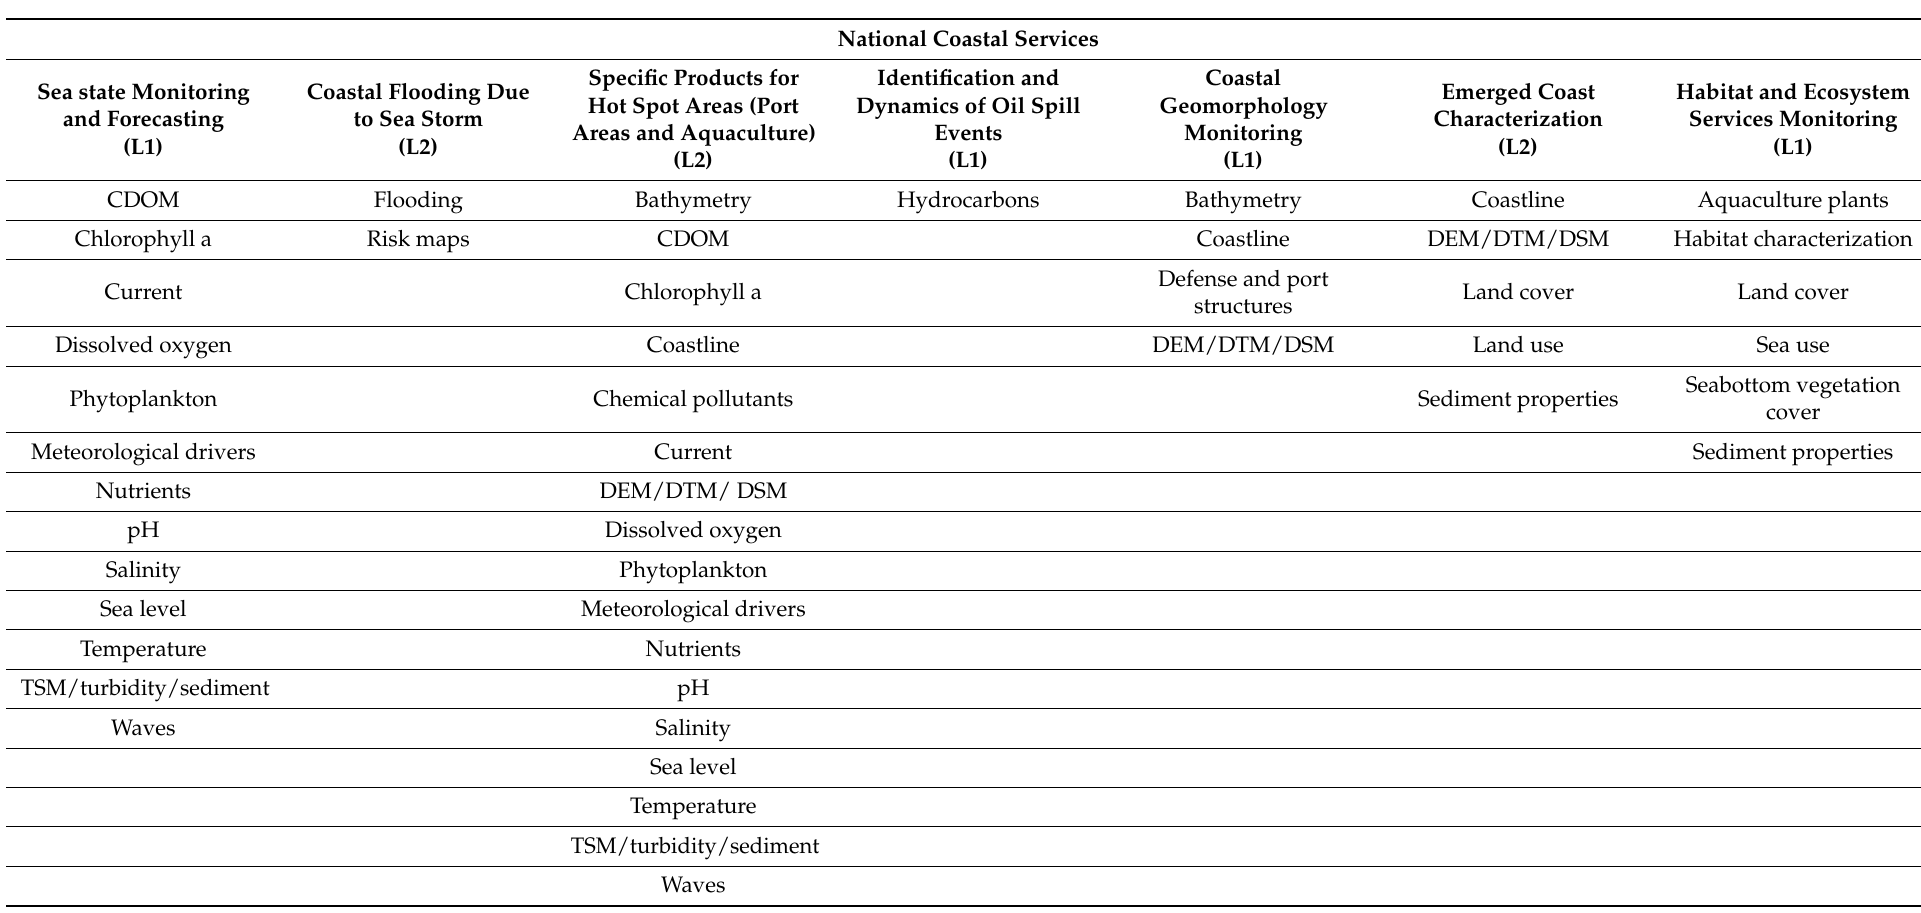
Table 3. National coastal services required by institutional users and relative provided